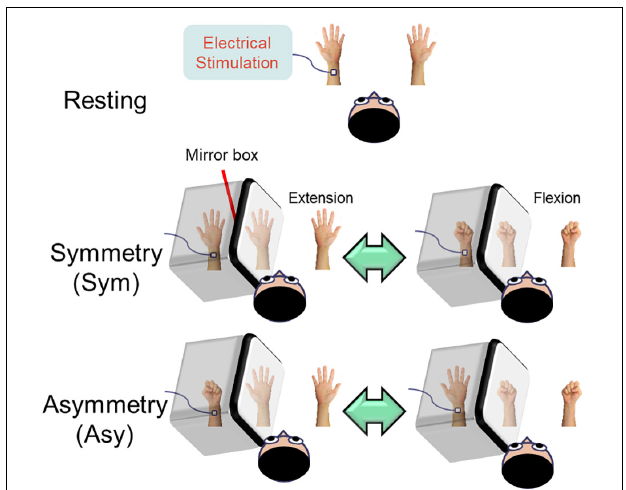
FIGURE 1 | Illustration of the experimental design. In the resting condition, the subjects were instructed to look at both stationary hands. In the symmetry (Sym) condition, the subjects performed bimanual in-phase fingers flexion/extension with a mirror covering the left hand. In the asymmetry (Asy) condition, the subjects performed bimanual out-of-phase fingers flexion/extension with a mirror covering the left hand, which produced a conflict between hand movements and visual feedback. During the whole experimental procedure, the left median nerve was stimulated at the wrist in order to probe the beta rebound activities of the motor